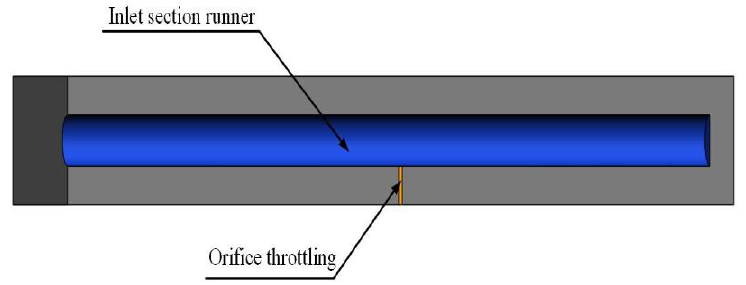
Figure 1. Schematic diagram of the orifice restrictor.